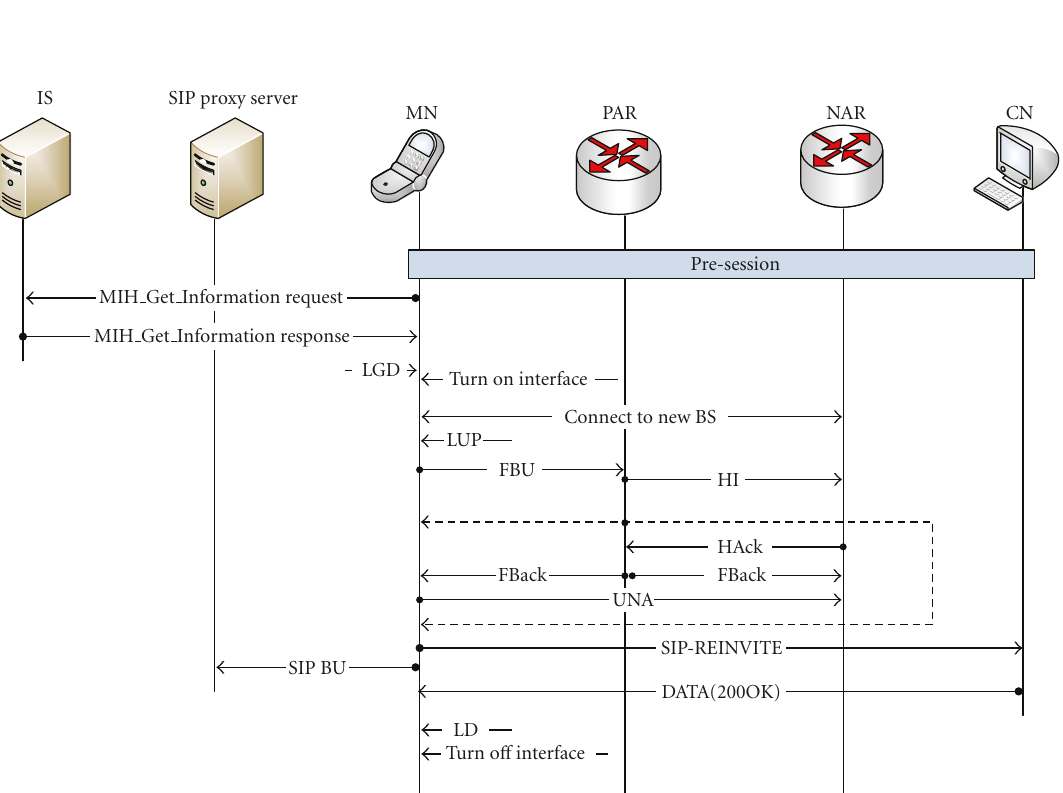
Figure 2: Signaling flows of the OSM.